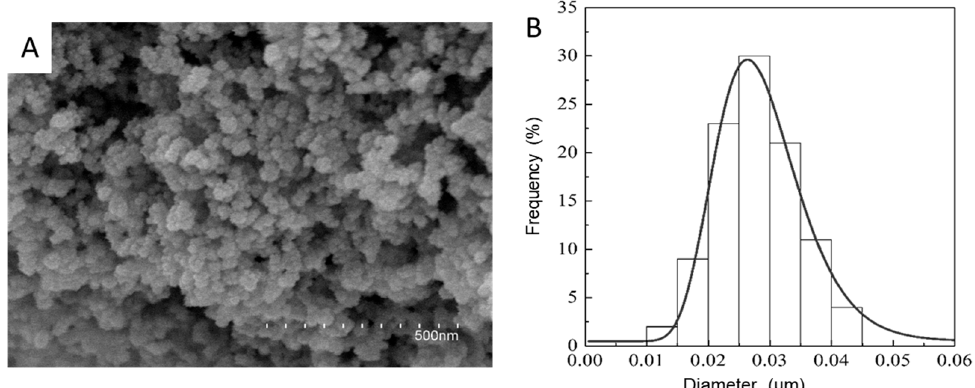
Figure 4. ( A ) Field emission scanning electron microscope (FESEM) image of nanostructured silica (SiO 2 ) microparticles after electrospraying. ( B ) Histogram showing the particle size distributions of the SiO 2 nanoparticles in the aggregates.